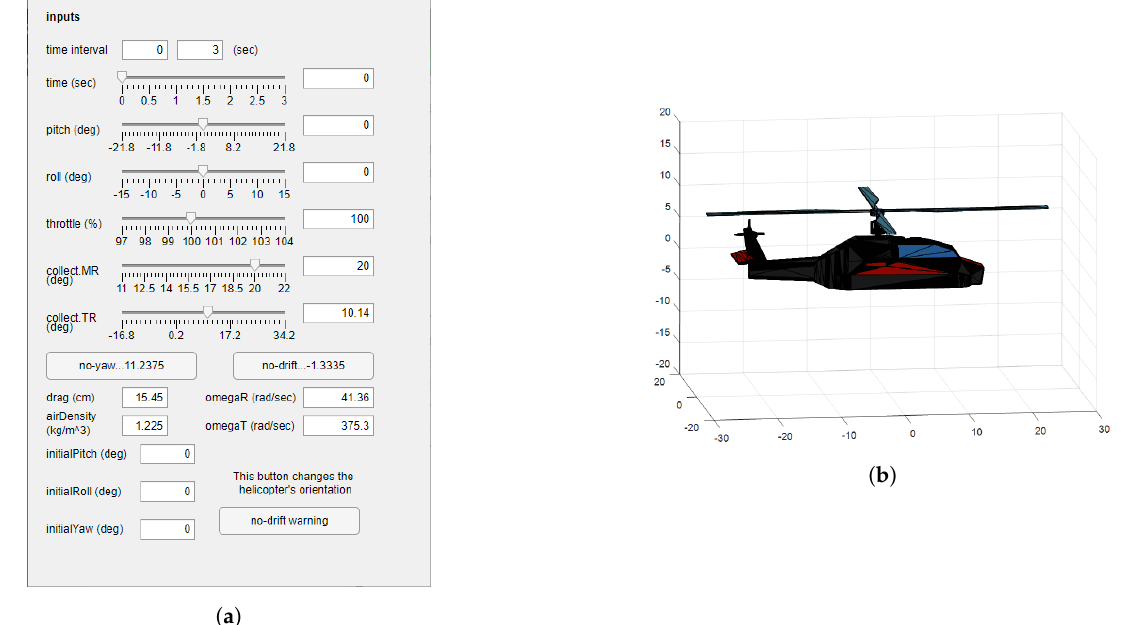
Figure 10. Graphic input interface: ( a ) graphic interface used to test the model; ( b ) graphic window to show the initial attitude of the helicopter, which is linked to the value of the matrix R